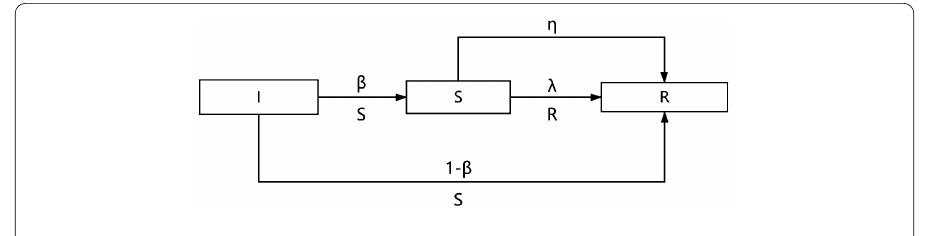
Figure 1 Schematic diagram of SIR rumor